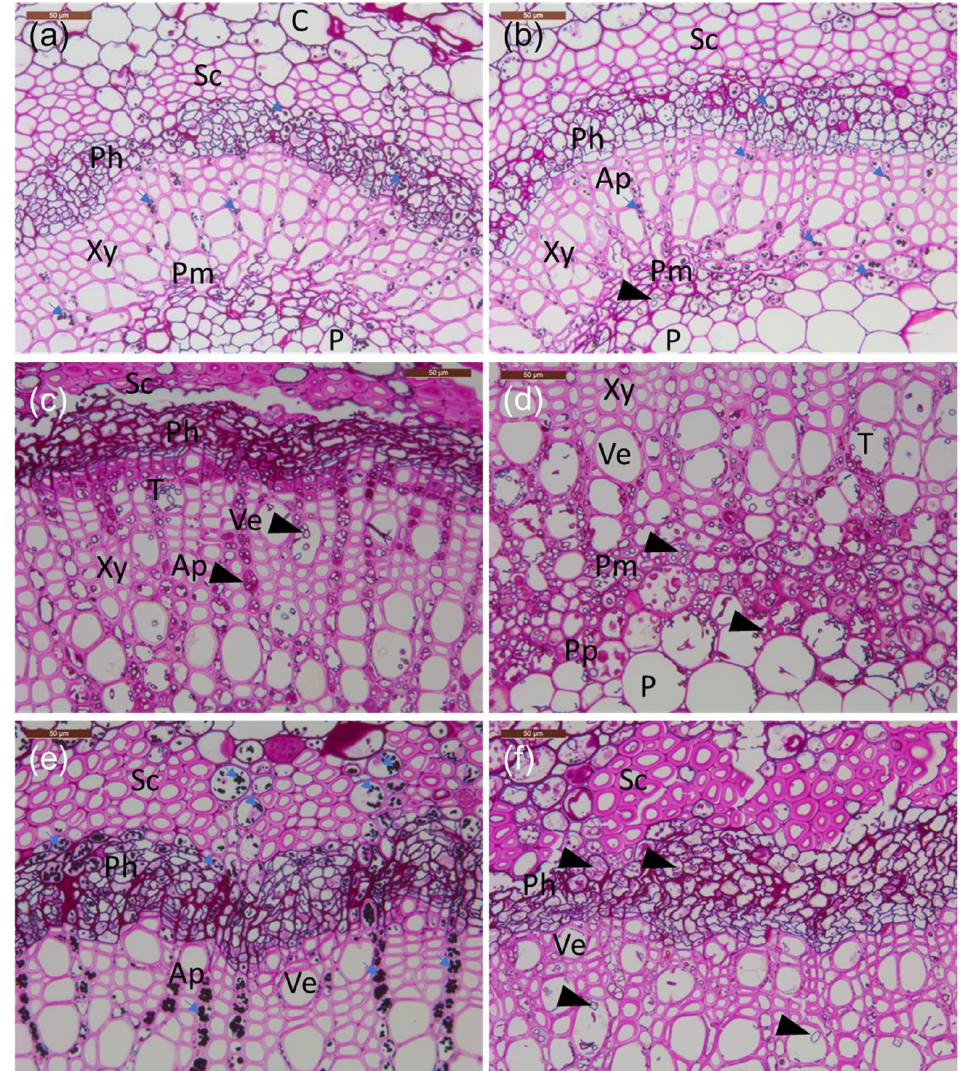
Figure 3. Transverse sections of petioles from the lesion border of inoculated rachis samples compared to healthy tissue. ( a − e ) Common ash clones; ( f ) Manchurian ash clone. ( a ) Healthy clone 35. ( b ) Infected clone 35. ( c ) Infected clone 27x; note the phloem with less amount of starch and presence of large amounts of hyphae and phenolics. ( d ) Infected clone 27x; note the abundant presence of mostly axially orientated hyphae in the perimedullary pith. ( e ) Infected clone 14165 with a large amount of starch grains filling the cortex parenchyma, phloem, and axial parenchyma aligning vessels. ( f ) Infected Manchurian ash clone 1989-0095-4 with a low amount of starch and the presence of axially and occasionally laterally orientated hyphae. All tissue sections were stained with PAS carbohydrate specific staining. C: cortex; Ph: phloem; Xy: xylem; P: pith; Sc: sclerenchyma; Pm: perimedullary parenchyma; Pp: polyphenolics; T: tylosis; Ap: axial parenchyma; Ve: vessel elements; small blue arrows: starch grains; arrowheads: fungal hyphae. Scale bars: a-f, 50 µm.